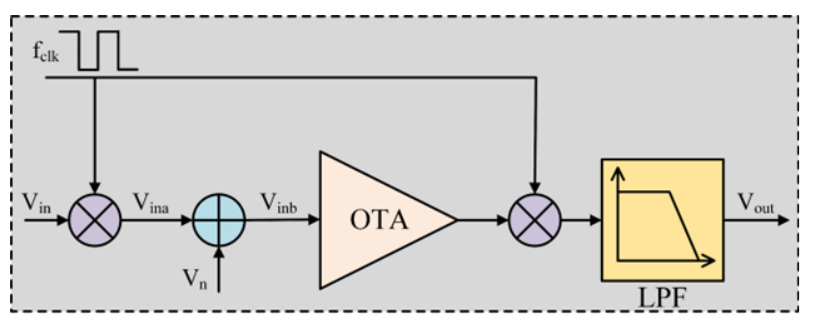
Figure 2. Flow chart of the chopper modulation signal.